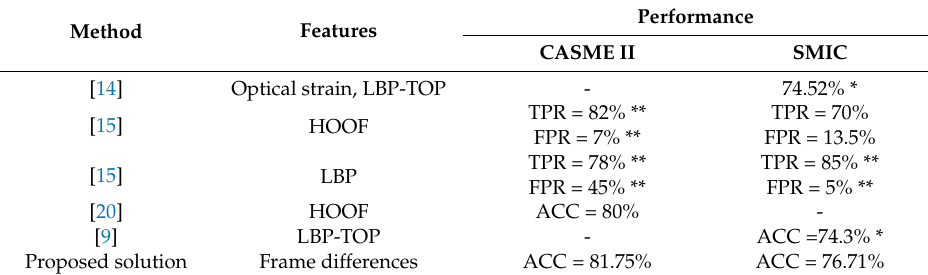
Table 6. ME detection performance—comparison with state of the art.